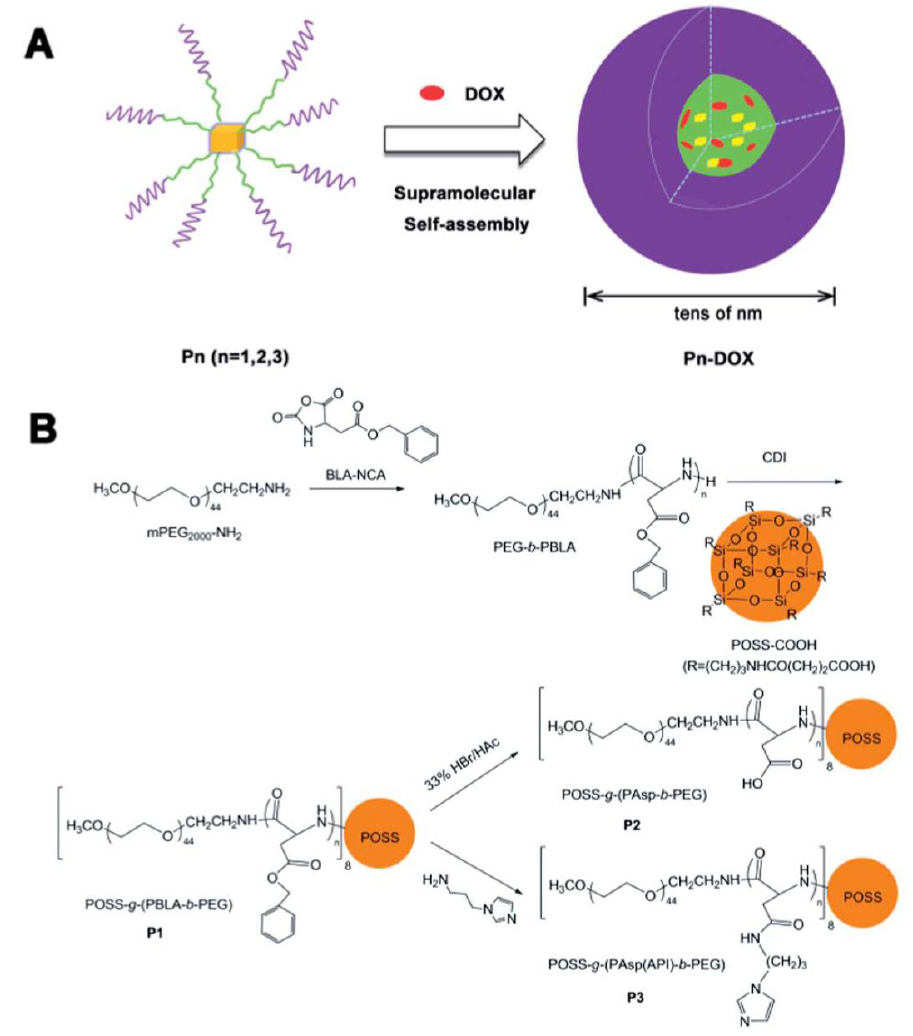
Figure 13. Schematic illustration of the DOX-loaded micelle formation ( A ) and the synthetic route of the star-shaped copolymers ( B ). P n represents for poly(benzyl L -aspartate)- b -poly(ethylene glycol) (PBLA- b -PEG) copolymers. Reprinted with permission from [28]. Copyright (2014) The Royal Society of Chemistry.